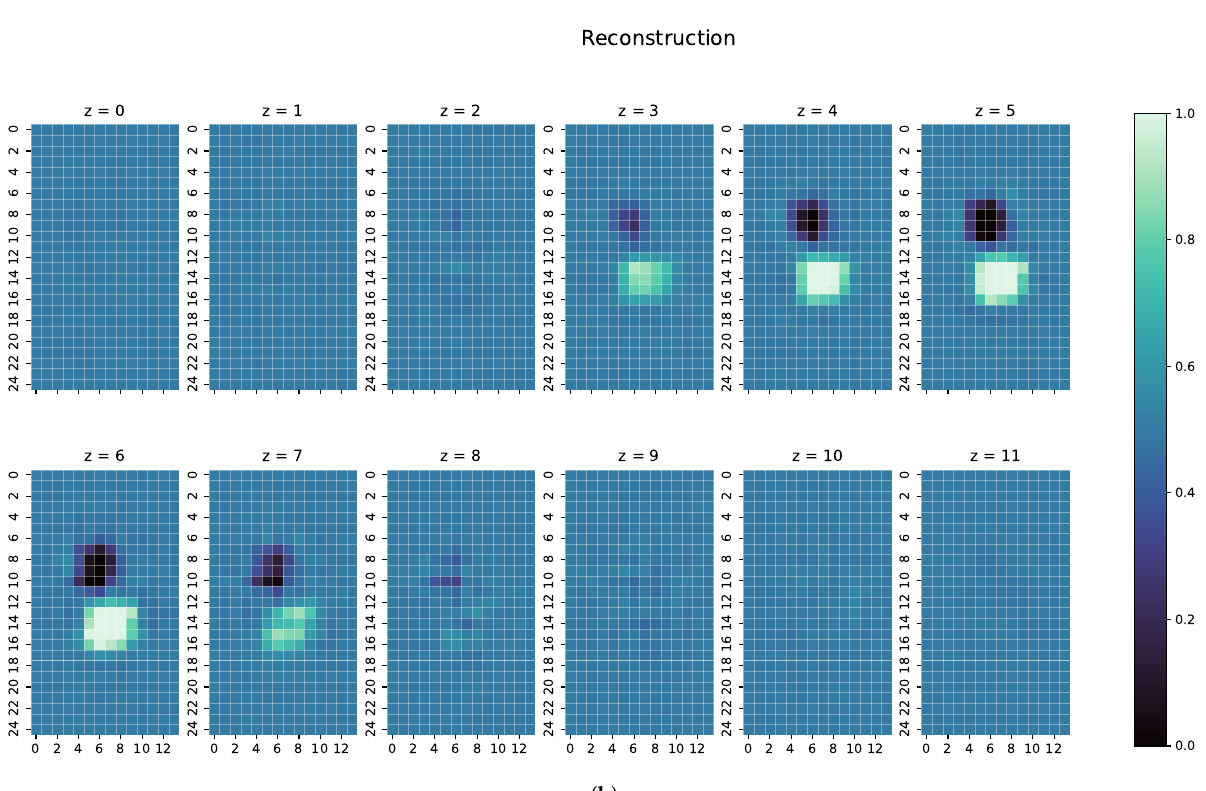
Figure 9. ( a ) Original conductivity distribution for case 3 of a real measurement. The body is discretised into 2 cm voxels, as in the simulation cases; thus, there are edge values with different conductivities. ( b ) Reconstruction of the conductivity distribution of case 3, as shown in ( a